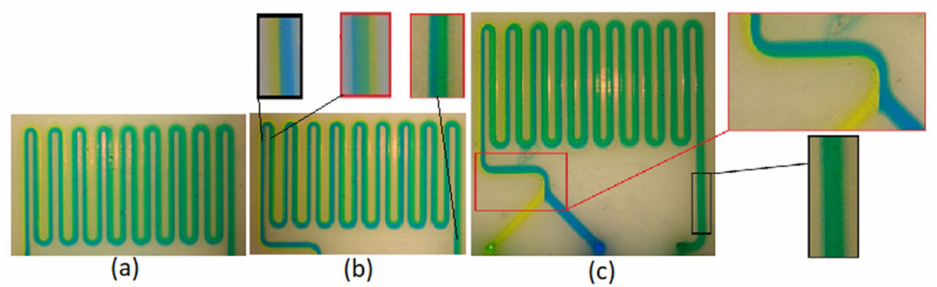
Figure 6. Mixing obtained in polyjet micro-mixer with di ff erent flow rates. ( a ) flow rate of 50 µ L / min; ( b ) flow rate of 200 µ L / min; ( c ) flow rate of 400 µ L /